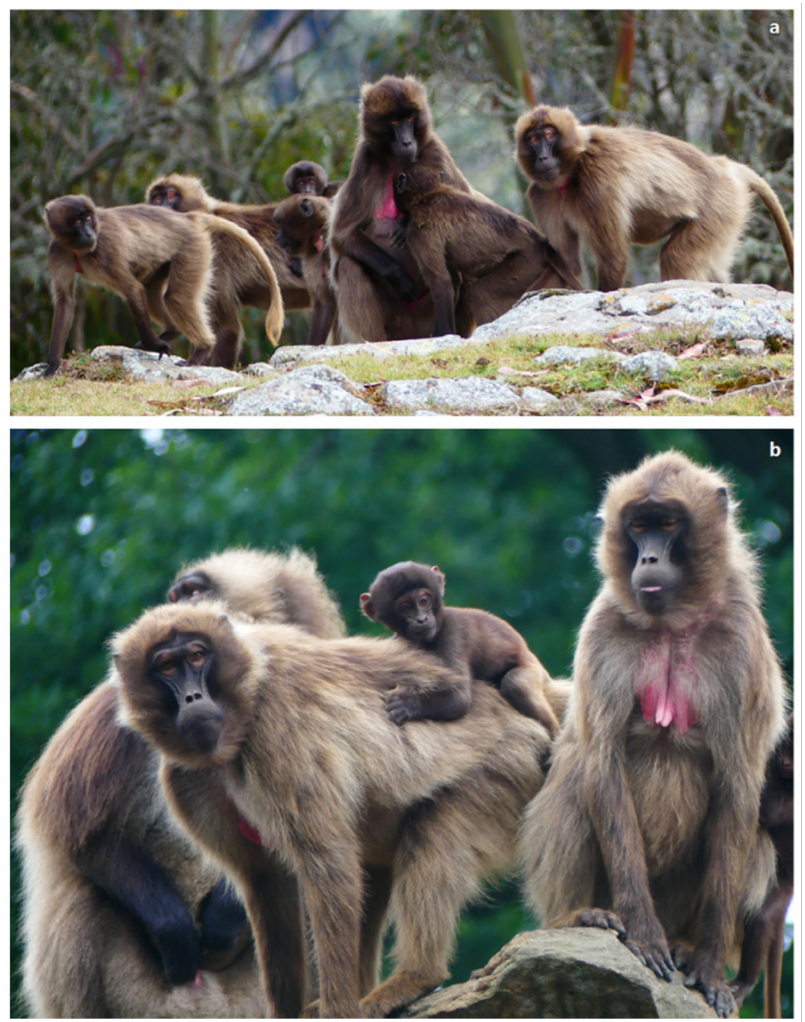
Figure 1. A group of adult females and immature subjects of geladas ( Theropithecus gelada ) ( a ) from the Kundi plateau in the Wof-Washa area (Amhara region, Ethiopia) and ( b ) from the NaturZoo (Rheine, Germany). Photo: Elisabetta